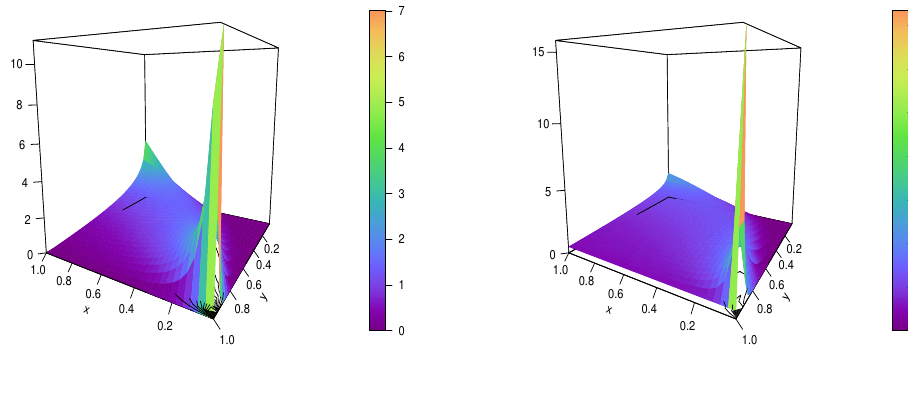
Figure 5. Plots of the IP copula density for α = 1 and β = 1 ( left ) and β = 1/2 ( right